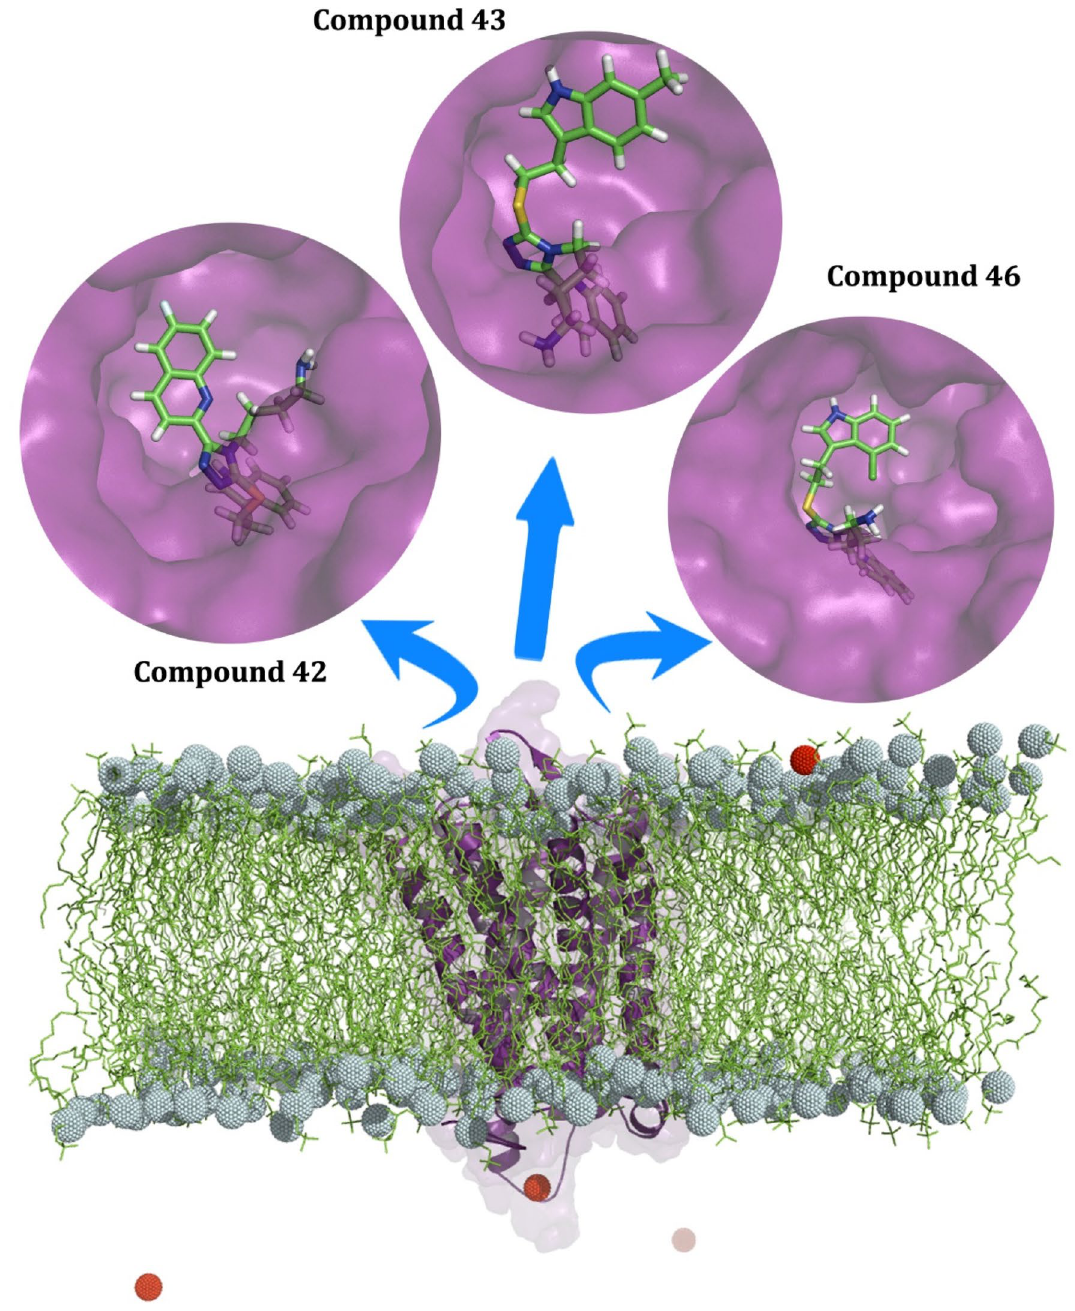
Figure 1. The figure represents the SSTR2 homology model embedded in a DPPC lipid bilayer. SSTR2 homology model is displayed as a purple colored cartoon representation. Lipid acyl chains and head phosphorous atoms are represented as green lines and cyan spheres, respectively. SSTR2 ligand molecules residing in SSTR2 binding site are represented in the circles. Ion molecules added in the system to neutralize the system charge are represented as red spheres. Figure generated using PyMOL 1.3 (http:// www. pymol. We plotted the change in RMSF of amino acid residues of the protein structure over the simulation time. After calculating the RMSF avg of SSTR2 residues, the stable and fluctuating residues were defined. RMSF avg for complexes with compounds S2-42 , S2-43 and S2-46 were 0.2124 nm, 0.1669 nm, and 0.1837 nm, respectively. Residues of the apo system showed an RMSF avg of 0.1687 nm. Residues L2.44, I2.43, A2.47, L2.46, D2.50, V3.45, E2.51, M3.46, I3.48, D3.49, and S3.47 were identified to be stable. Of these residues, V3.45, M3.46, S3.47, I3.48, and D3.49 were found to be stable in the ligand complexes than apo. In other words, in the apo system, the above-mentioned residues fluctuated above RMSF avg and found to be stable in systems in the presence of a ligand. Residues fluctuating beyond the RMSF avg were identified and most of them were found to localize either in loops or in terminal domains. Figure 3 represent the change in RMSF of SSTR2 residues in the presence and absence